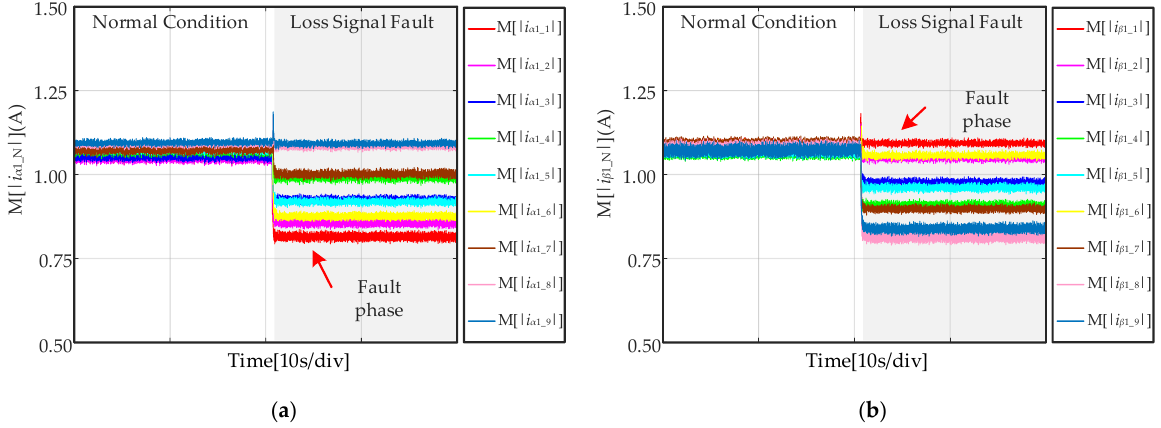
est one of the nine M[| i β 1_ N |].